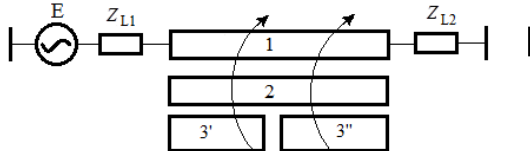
Fig. 4. Split strip line segment, strips 1 and 2 are connected in parallel.